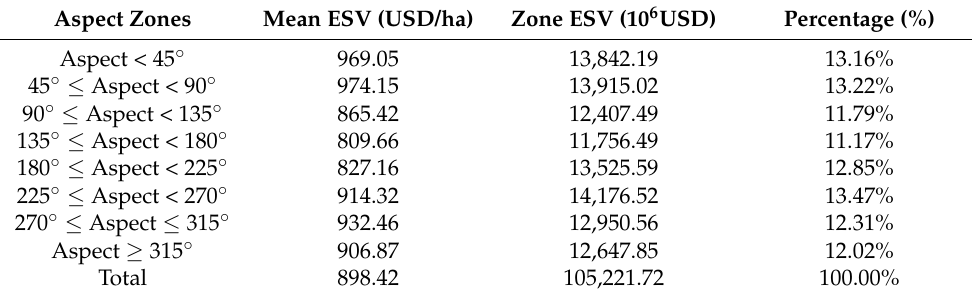
Figure 6. ESV of grassland ecosystem in the different elevation and slope zones. ( a ) the five ESVs in each elevation zone (the elevation range of zone 1~6: ≤ 500 m, 500~1000 m, 1000~1500 m, 1500~2000 m, 2000~2500 m, and ≥ 2500 m). ( b ) the variation in mean ESV with elevation. ( c ) the ESV in each slope zones (the slope range of zone 1~6: ≤ 5 ◦ , 5 ◦ ~8 ◦ , 8 ◦ ~15 ◦ , 15 ◦ ~25 ◦ , 25 ◦ ~35 ◦ , and ≥ 35 ◦ ). ( d ) the variation in mean ESV with slope. Table 6. Statistics of ecosystem service value of grassland types for the aspect